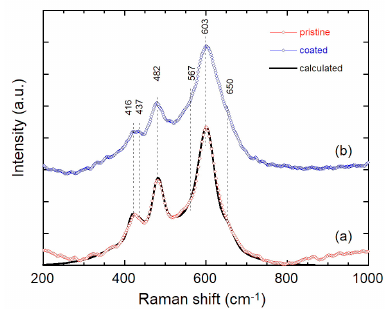
Figure 6. Raman spectra of LLNMO materials recorded with the laser excitation line at 532 nm. The solid black line represents the calculated